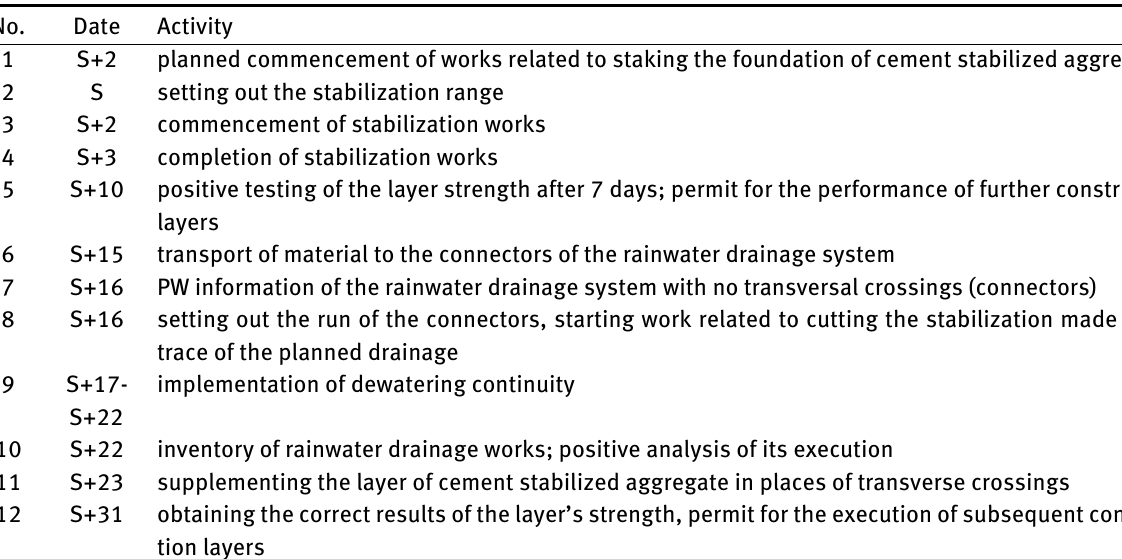
Table 3: Separate part of the schedule in which the R3 factor occurred, Source: own elaboration. No.